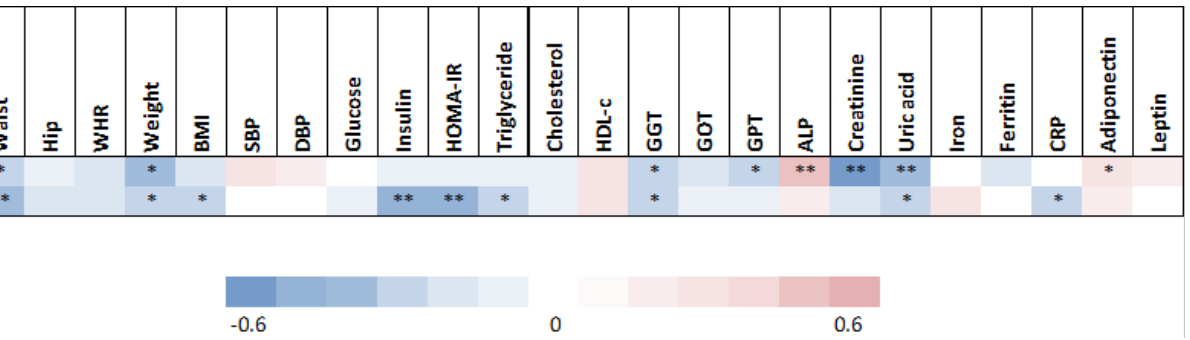
Figure 2. Correlations between clinical and metabolic parameters and adipose tissue ZAG levels.